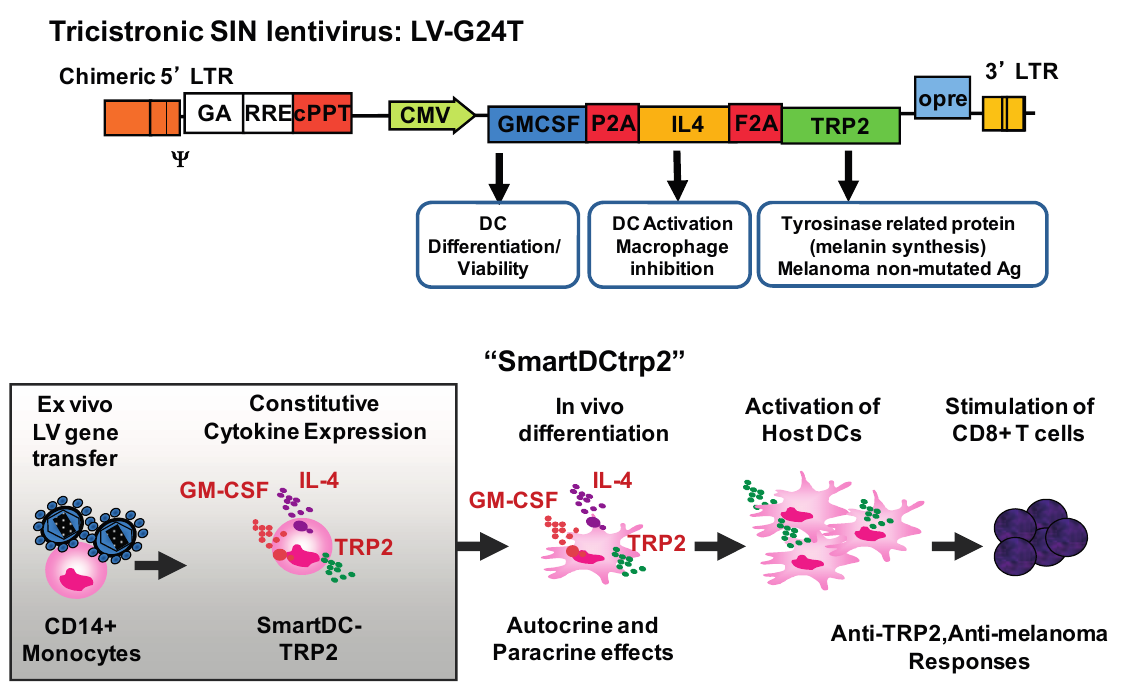
Figure 2. Tricistronic lentiviral vector design validated for production of